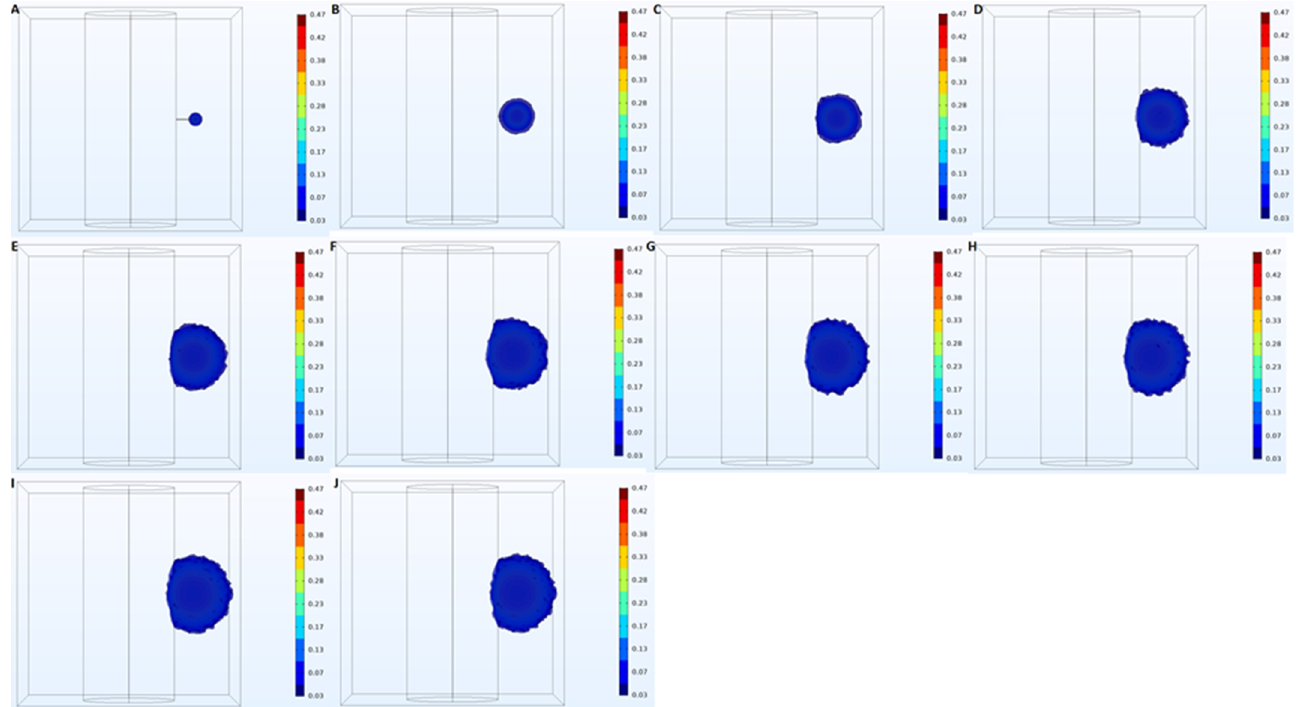
Figure 10. Variation in volume fraction of slurry solid particles δ with grouting time t : ( A ) 10 min, ( B ) 20 min, ( C ) 30 min, ( D ) 40 min, ( E ) 50 min, ( F ) 60 min, ( G ) 70 min, ( H ) 80 min, ( I ) 90 min, and ( J )